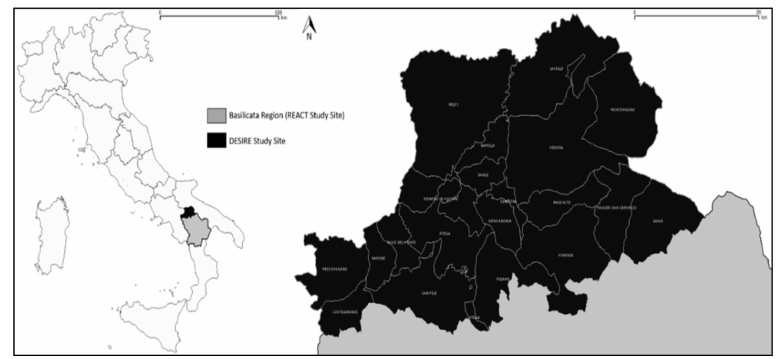
Figure 1. The location of the Basilicata region in southern